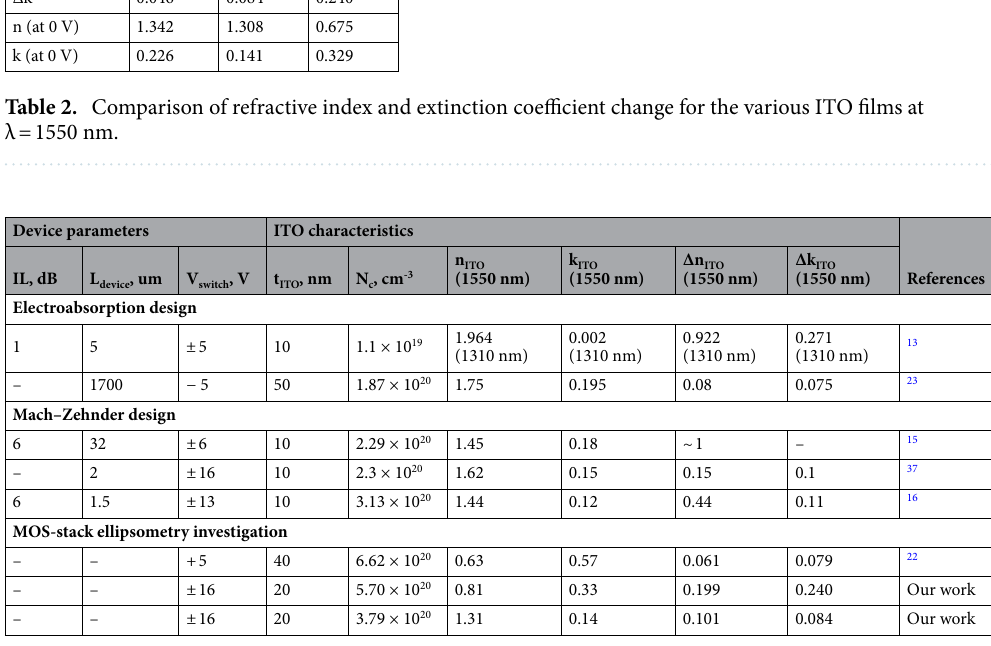
Table 3. Comparison of ITO characteristics and electro-optical device parameters in recent works.